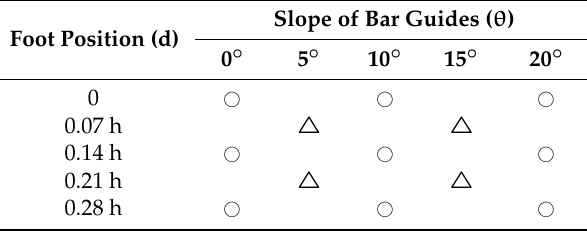
Table 1. Experimental planning for Smith squats (